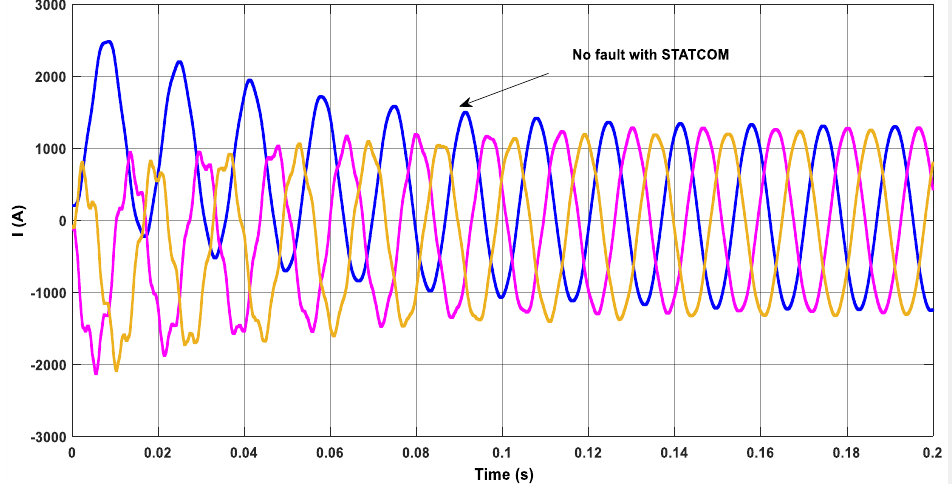
Figure 7. Three-phase current waveform under normal conditions with midpoint